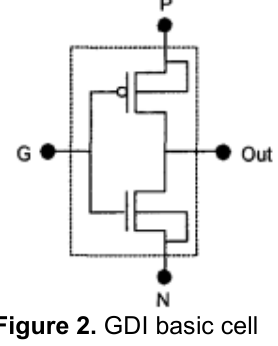
Figure 2. GDI basic